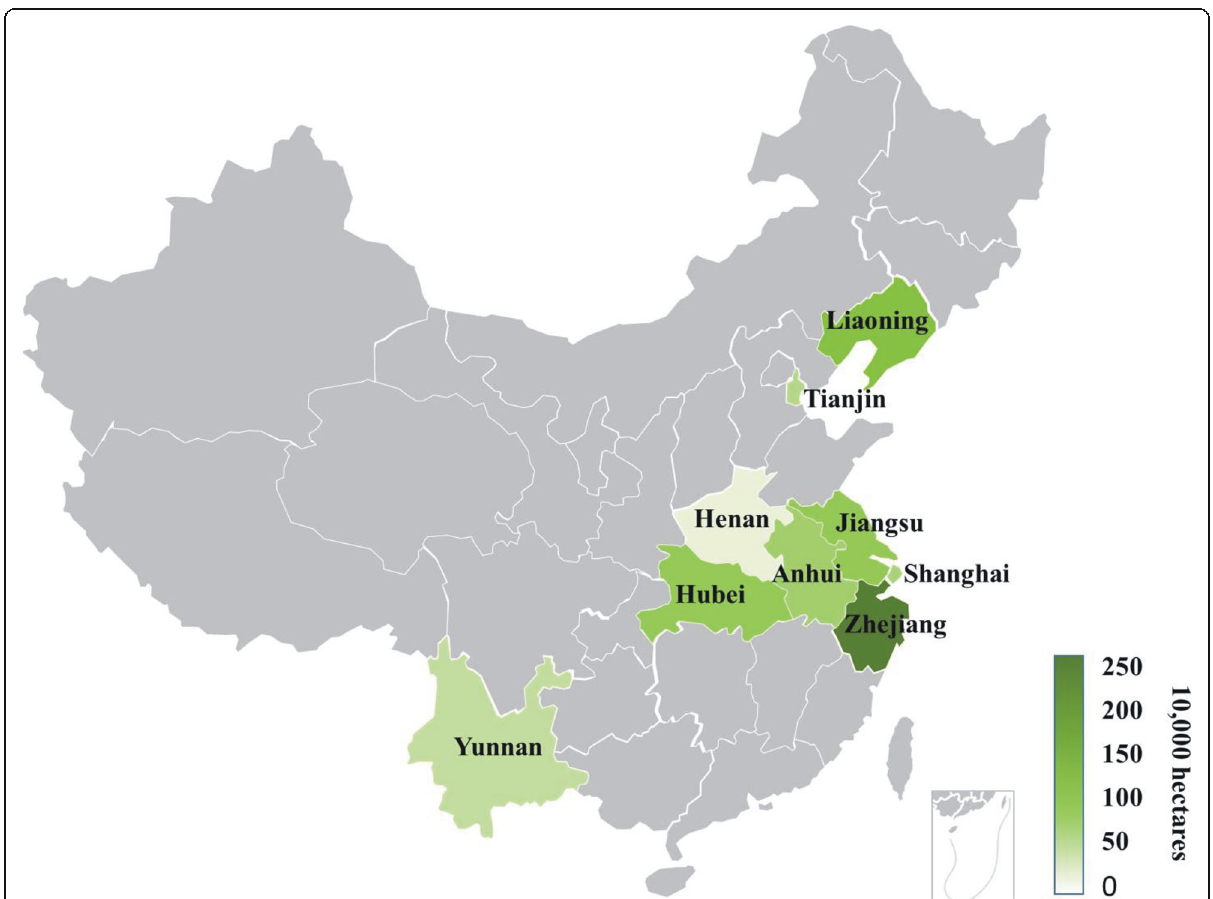
Fig. 4 Production map of hybrid japonica rice of China. The provinces marked green are those with a cumulative promotion area of more than 10,000 ha from 1981 to 2018. The deeper the green degree, the larger the cumulative promotion